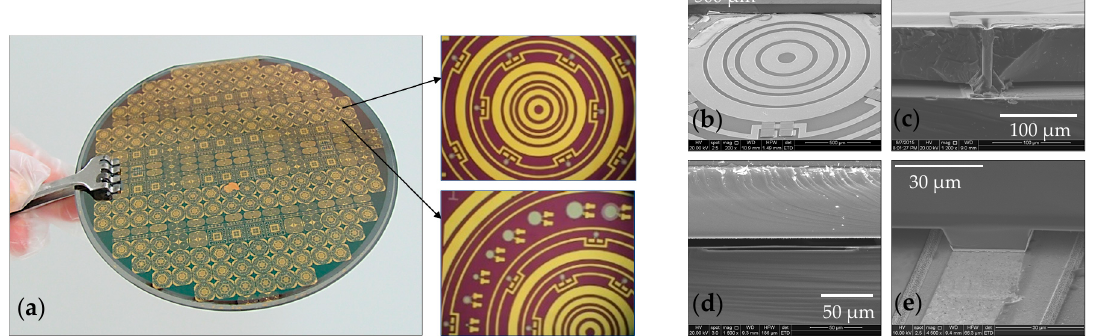
Figure 7. ( a ) Microscope images of whole wafer, circular device structure and individual PMUTs. ( b ) scanning electron microscope (SEM) image of a device with partially peeled-off cap, ( c ) close-up view of a TSV, ( d ) cross-sectional view of a PMUT, and ( e ) close-up view of a bonding interface.